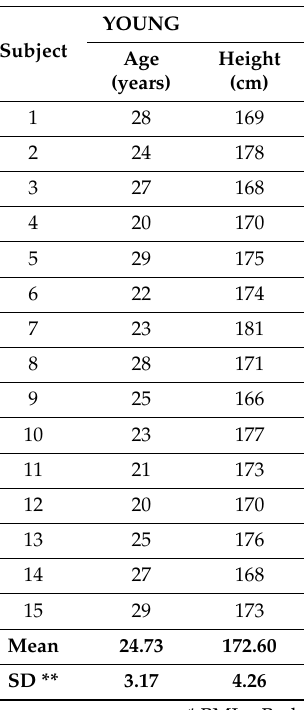
Table 1. The anthropometric characteristics of the